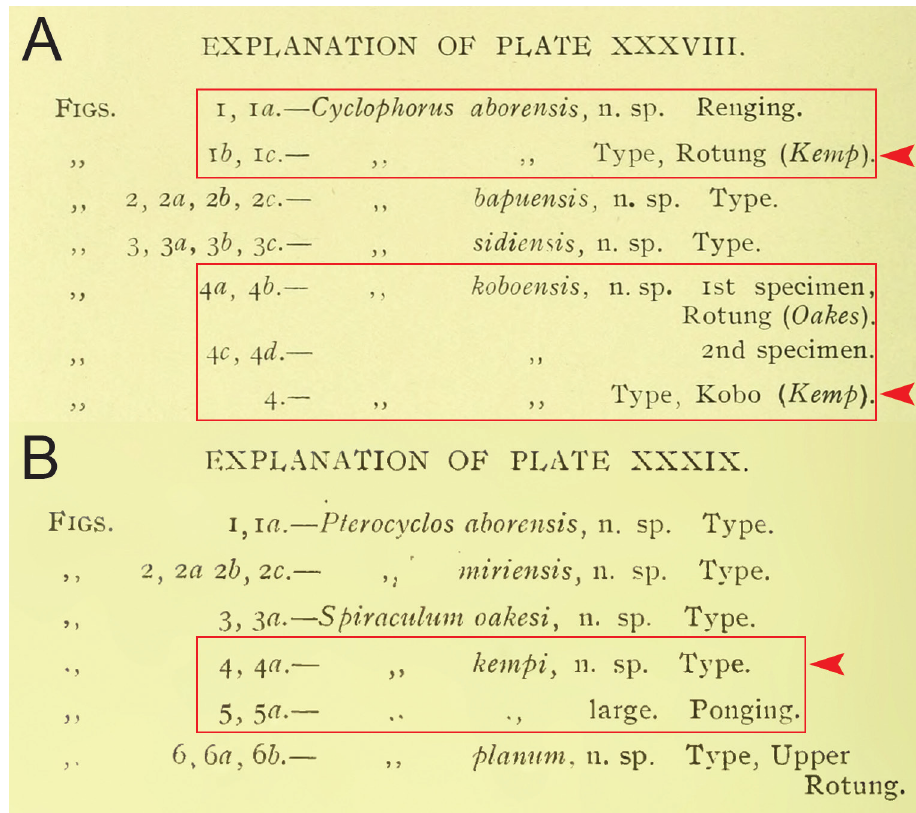
Figure 1. Figure caption with no page number of some cyclophorid taxa originally described by Godwin- Austen (1915) in A plate 38 and B plate 39. Red boxes indicate the figure caption of the same taxa. Red arrows indicate the annotation of “Type”. Credit: The Biodiversity Heritage